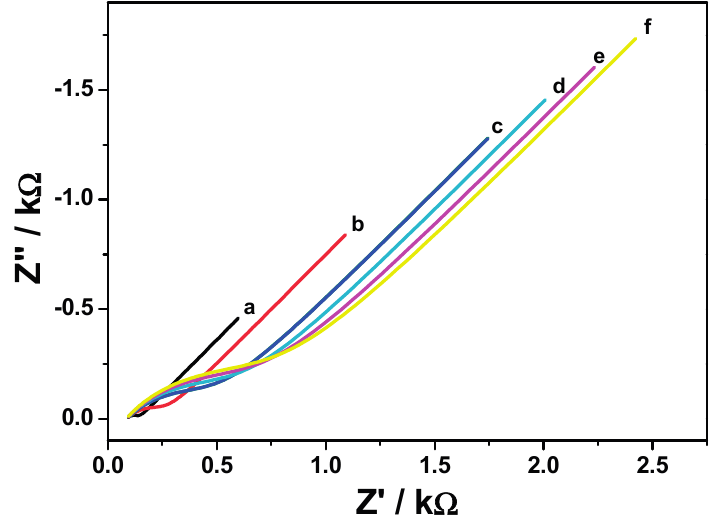
Figure 10. EIS response of FB 1 immunosensor (GCE/PT-PDMA-MWCNT/anti-Fms-BSA) at different concentrations of 0 (a); 14 (b); 21 (c); 28 (d); 35 (e) and 42 (f) ng L − 1 ) in